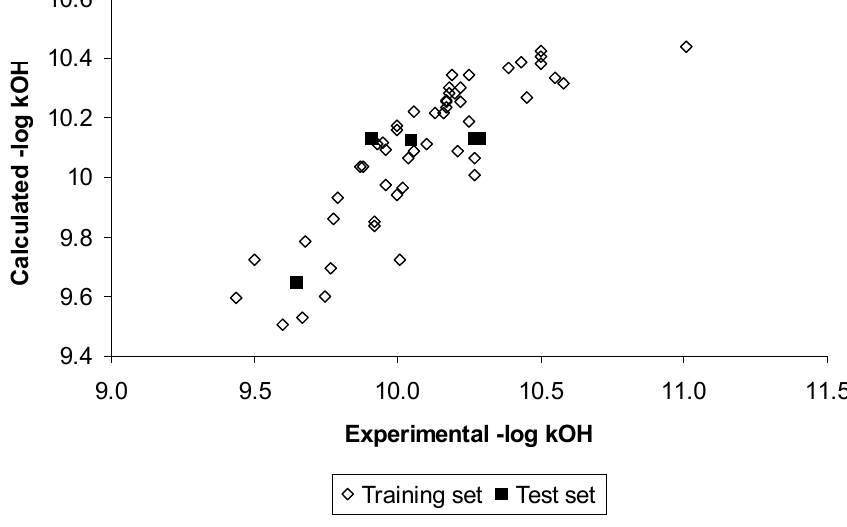
) values using variable connectivity index (Model OH